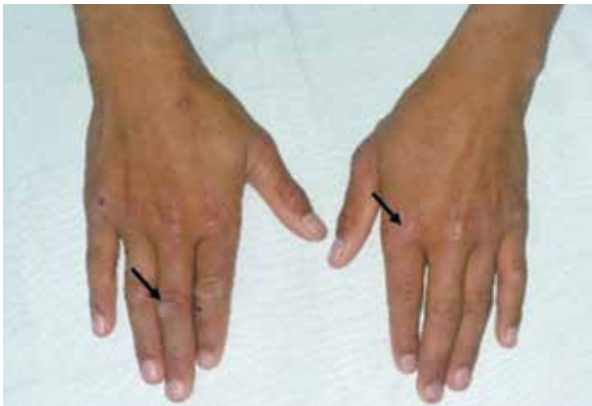
Fig 2. Multiple violaceous papules (Gottron’s papule) over IP and MCP joint